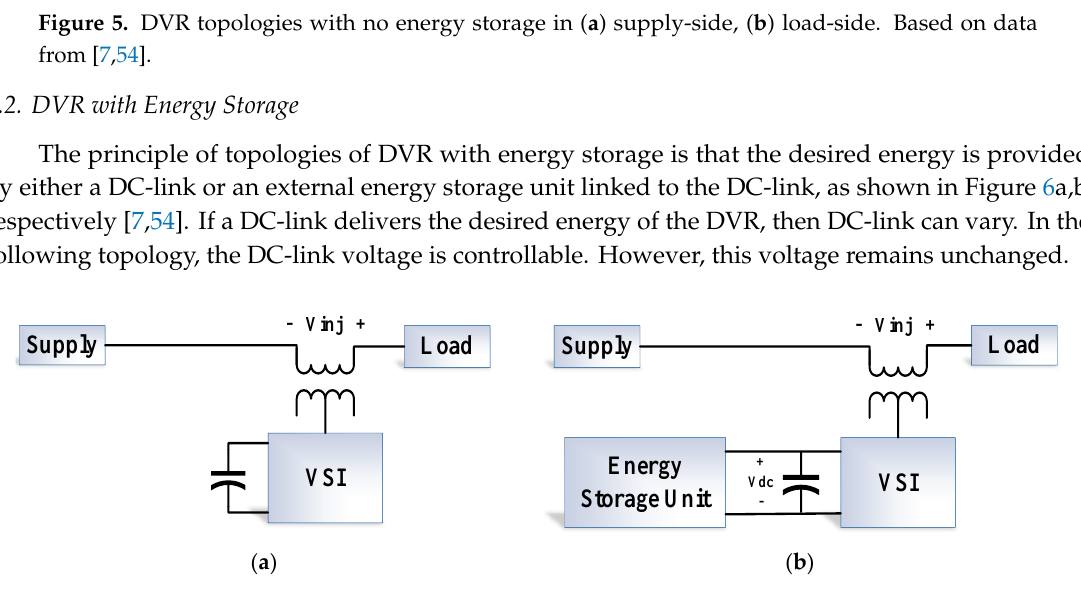
Figure 6. DVR topologies with energy storage: ( a ) capacitor, ( b ) with the external energy storage unit. Based on data from [7,54]. Table 5. The advantages and disadvantages of DVR topologies. Based on data from [7,54].